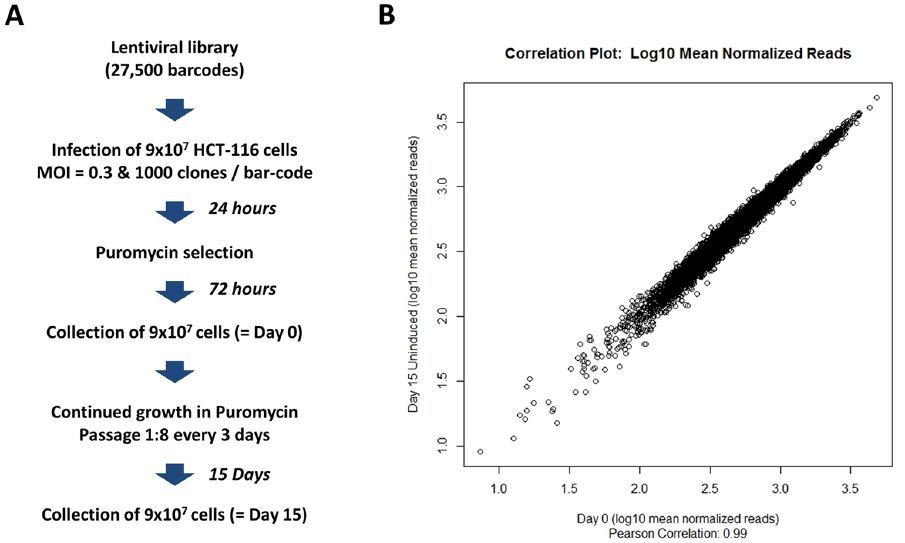
Figure 3. Evidence that encoded shRNA are not induced in the absence of Doxycycline invitro. (A) A lentiviral library containing 27,500 unique barcodes was used to transduce HCT-116 cells at a MOI of 0.3. After 72 hours, of puromycin selection, cells were continuously passaged for 15 days in the absence of Doxycycline. Day 0 and Day 15 cell aliquots were obtained and total DNA from both time points were subjected to the barcode high-throughput sequencing retrieval procedure. (B) Correlation plot for Day 15 measurement against Day 0. shRNA barcode reads for all samples from all time points were first normalized to 2 6 10 7 reads. Values for triplicate samples were averaged. At Day 15, strong repression of shRNA expression in the absence of Doxycycline is evident in the correlations with the Day 0 reference. Plot of log10 mean normalized reads for Day 0 against Day 15 (Pearson correlation: R=0.99).